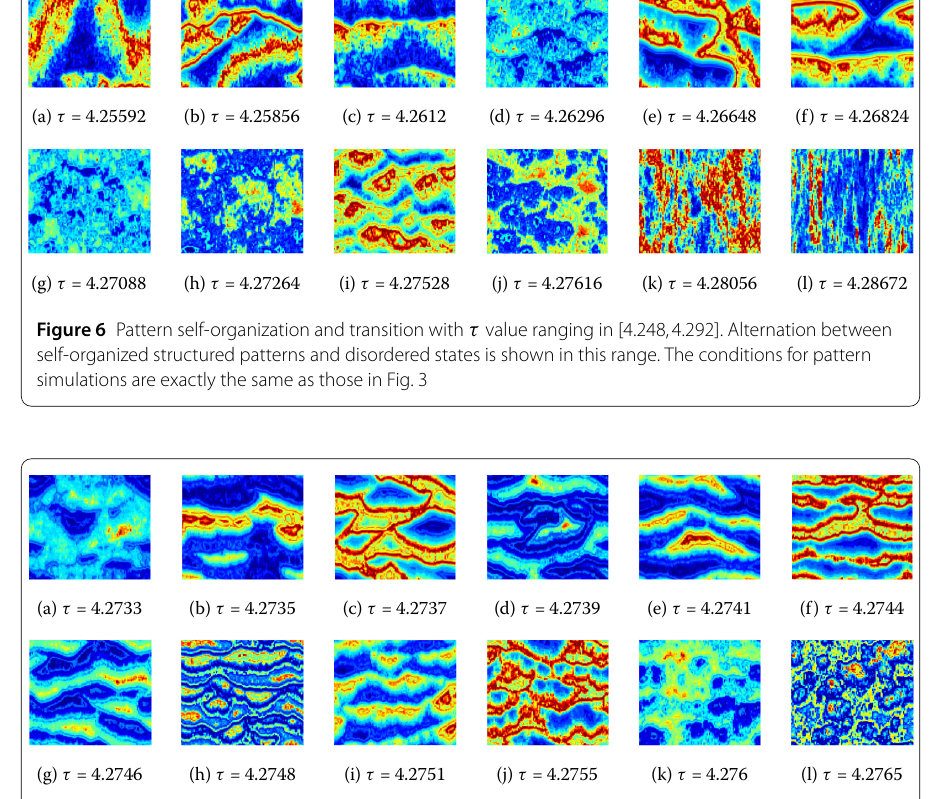
Figure 7 Pattern self-organization and transition with τ value ranging in [4.272,4.277]. Cyclic transitions of patterns are found in the alternation between ordered patterns and disordered states. The conditions